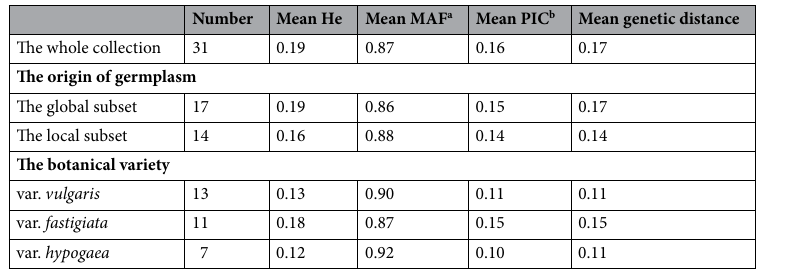
Table 2. Genetic diversity in the 31 accessions of Taiwanese peanut germplasm. a MAF, major allele frequency. b PIC, polymorphic information